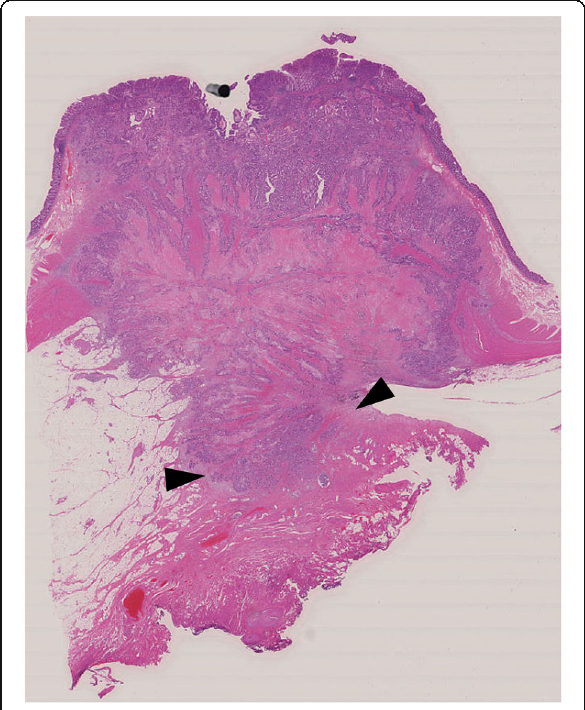
Fig. 5 Histological examination of the resected specimens from the rectum (HE Loupe image). The viable adenocarcinoma was mainly present in the submucosa and muscularis propria with a small range of invasion to the vagina (arrowhead). HE, hematoxylin and eosin